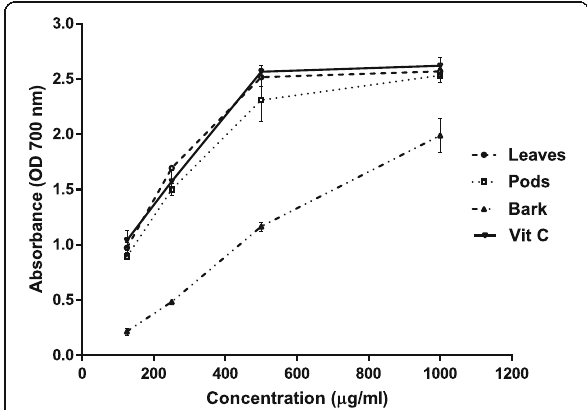
Fig. 1 Reducing capacity of leaves, pods and bark extracts